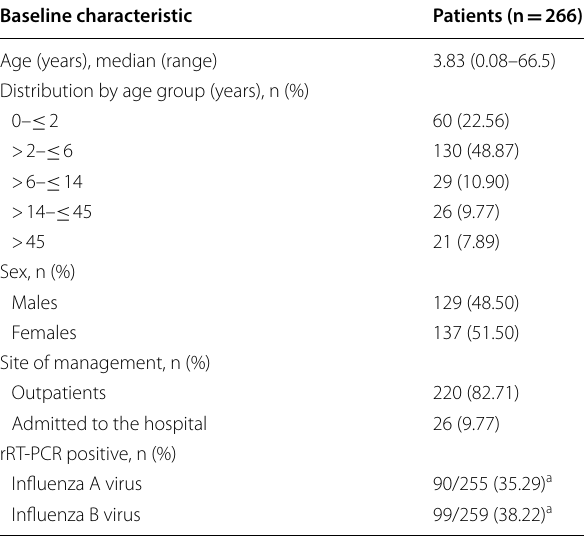
Table 2 Baseline characteristics of the patients with